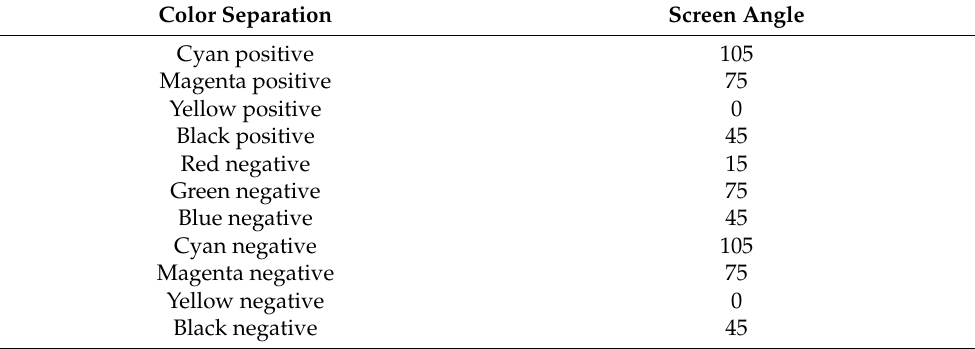
Table 4. Screen angles